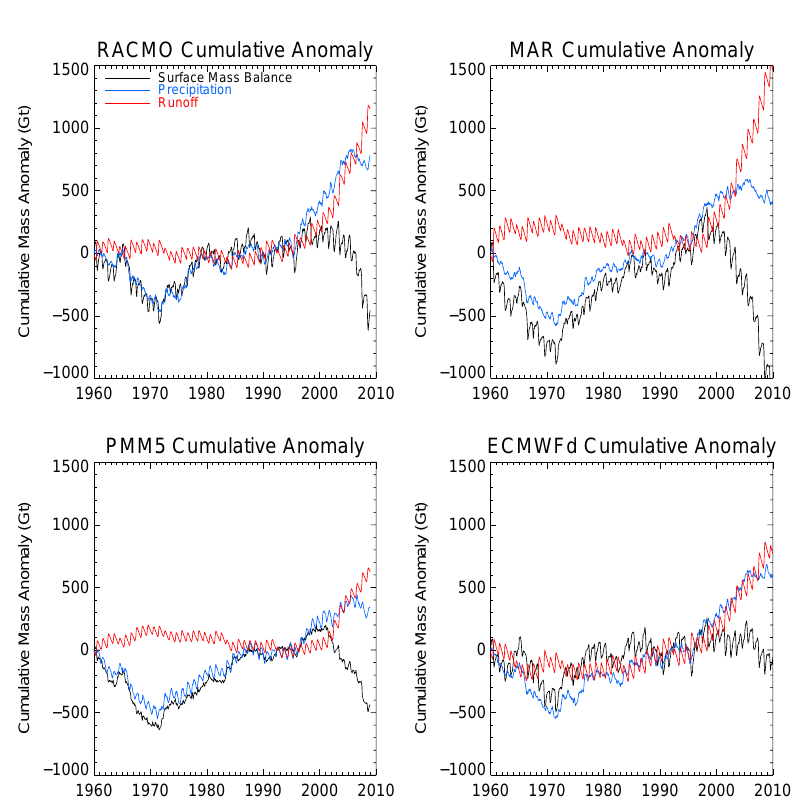
Fig. 5. SMB, precipitation and runoff cumulative anomalies from the 1961–1990 period for each model.